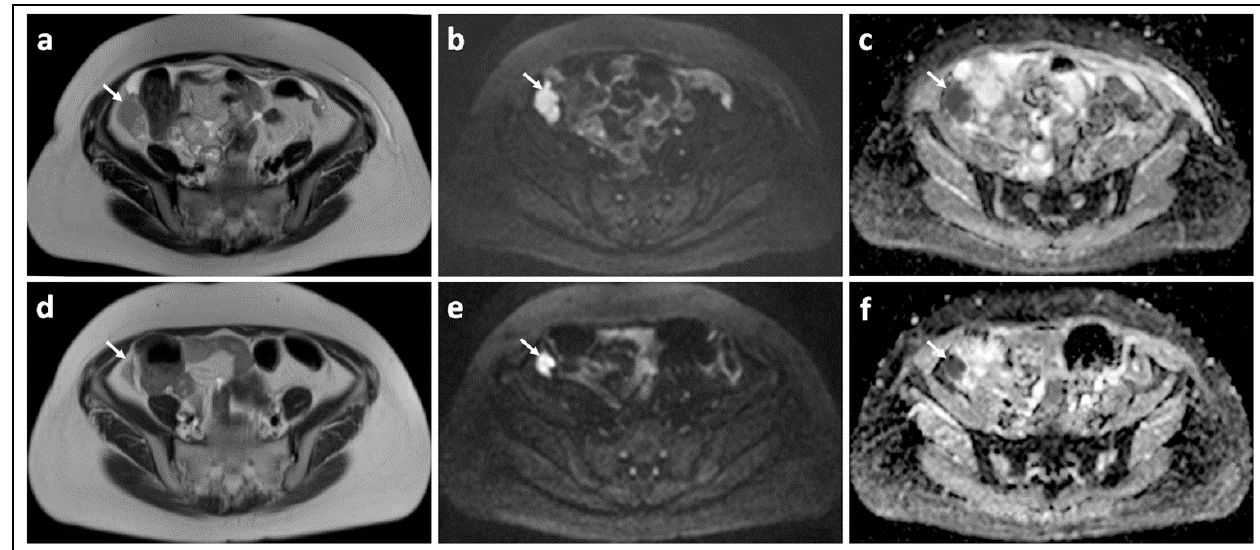
Figure 5. Peritoneal metastasis showing poor response to chemotherapy: T2-W image ( a ) and corresponding b = 900 s/mm 2 DW-MRI ( b ) and ADC map ( c ) through the upper pelvis in a patient with high grade serous ovarian cancer before treatment shows an irregular right-sided peritoneal metastasis. It is recognized by its homogenous solid appearance and marked diffusion restriction [arrows]. Corresponding slices of T2-W ( d ), b = 900 s/mm 2 DW-MRI ( e ) and ADC map ( f ) after three cycles of platinum-based chemotherapy illustrate that there has been marginal reduction in the size of this lesion.